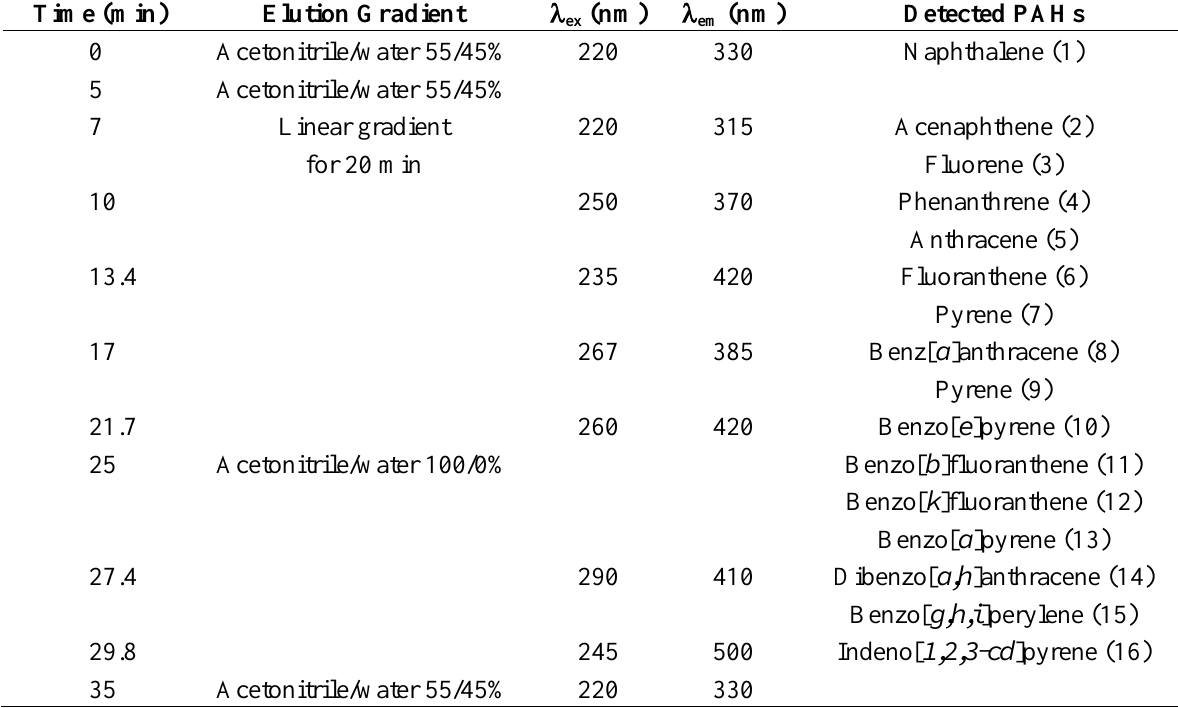
Table 3. HPLC elution gradient for the analysis of the 15 priority PAHs (defined by U.S. EPA) plus benzo[ e ]pyrene, and conditions for the fluorimetric